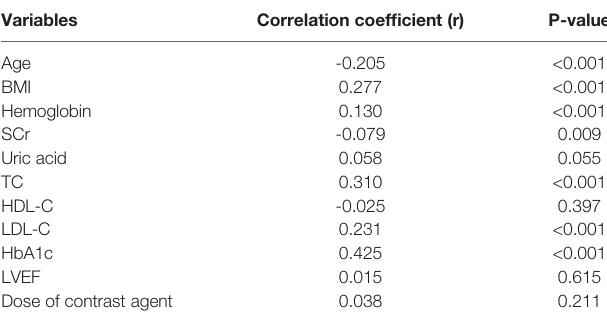
TABLE 2 | Correlation between TyG index and potential risk